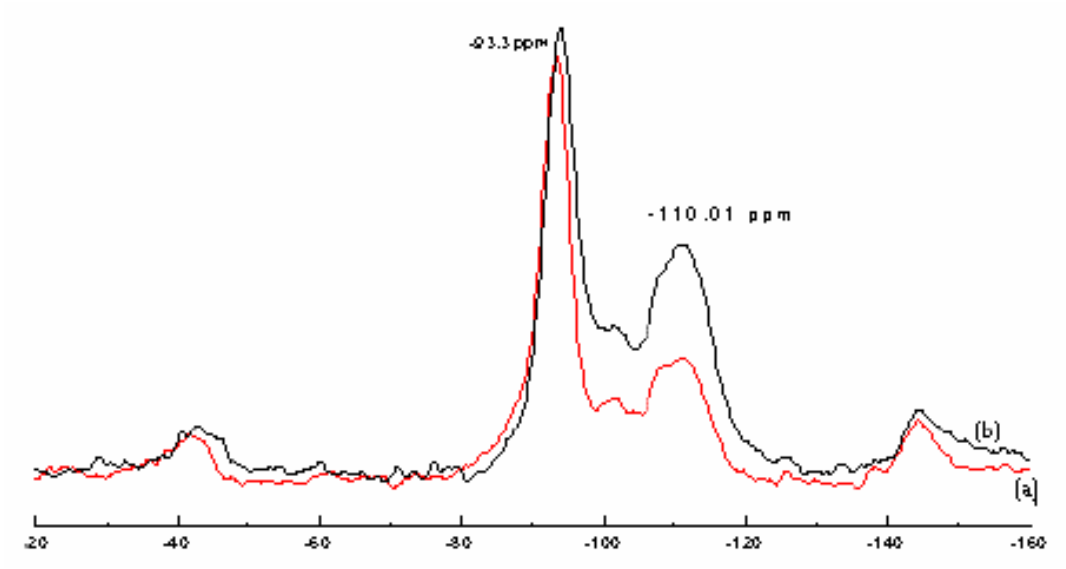
Figure 4. 29 Si MAS NMR spectra of (a) “Raw-Maghnite” and (b) “H-Maghnite0.25M”